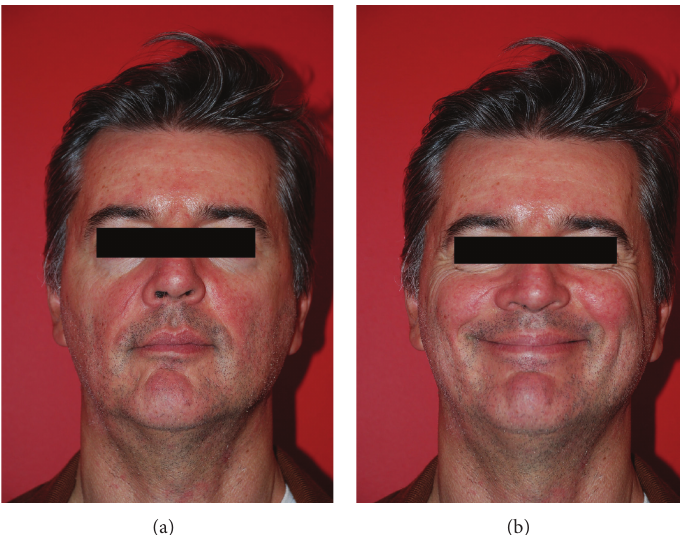
Figure 2: (a, b) Frontal view after one-year follow-up. After 2 sessions of autologous fat grafting pain sensation was resolved and we obtained scar release. In (b), the total restoration of mimic movements is